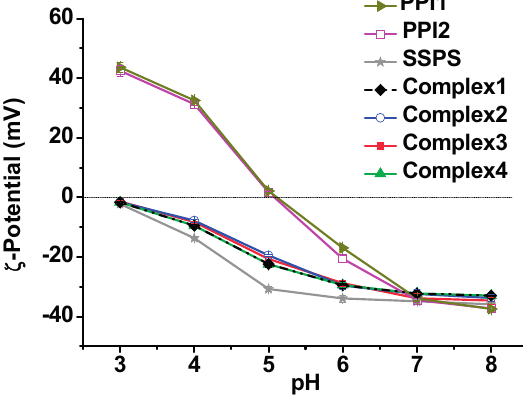
Figure 8. ζ -Potentials of PPI, SSPS, and complex emulsions as a function of